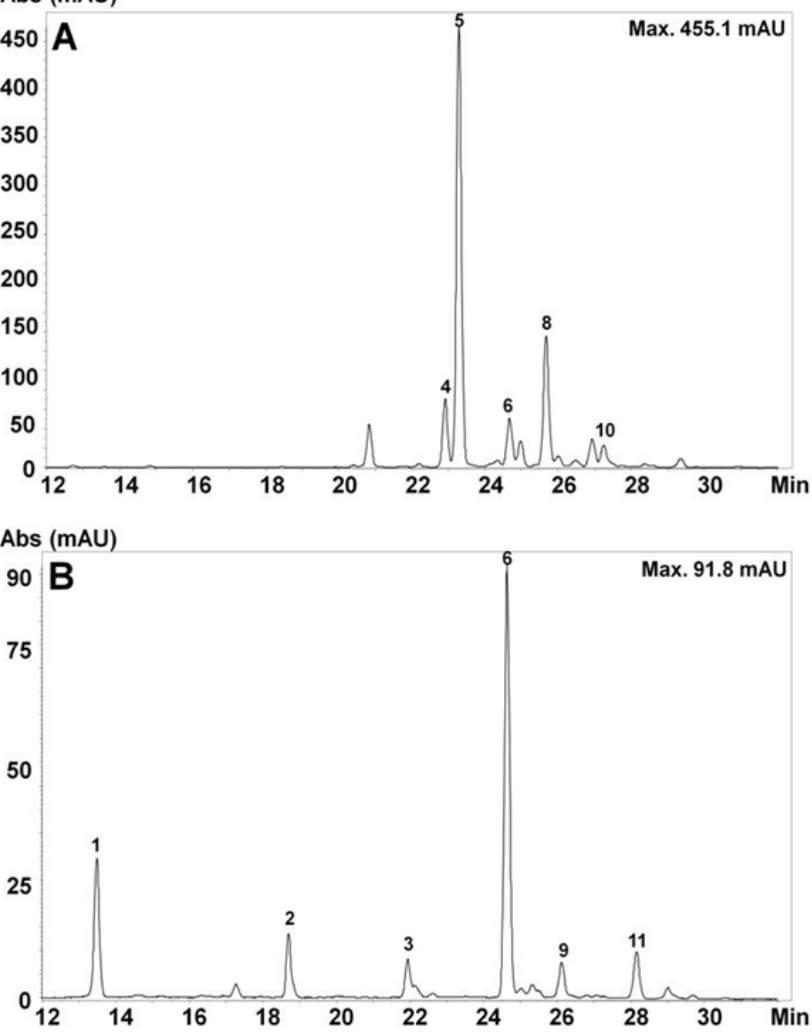
Figure 1. High-performance liquid chromatography diode array detection (HPLC-DAD) chromatograms of anthocyanins of fresh colored fleshed potatoes from southern Chile (520 nm). Identity assignment of anthocyanins according to Table 1. Where: ( A ) purple-fleshed potatoes (CB2011.104), ( B ) red-fleshed potatoes (TR2012.078).